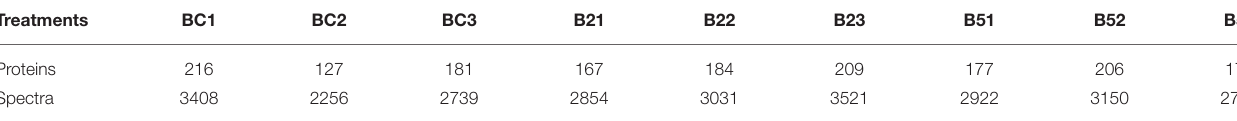
TABLE 1 | Total number of proteins identified at 95% protein probability and total spectra at 95% peptide probability, with minimum of two peptides. Treatments